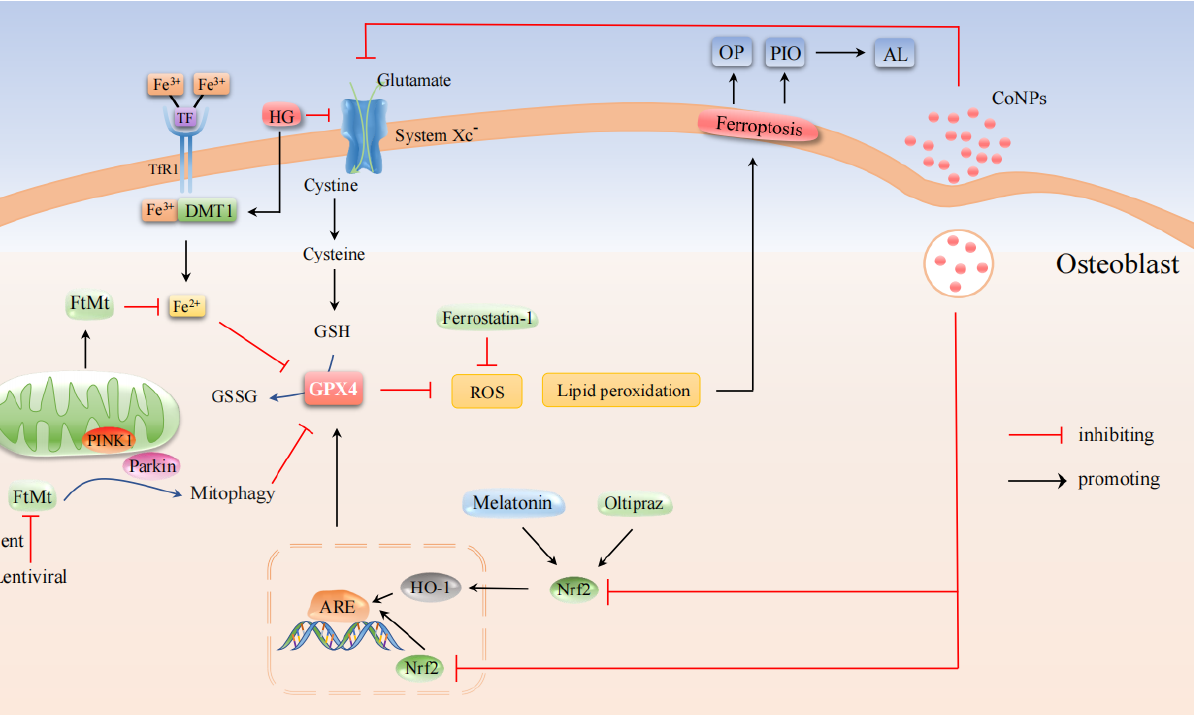
Figure 2. Molecular pathways in the regulation of OP-associated osteoblasts by ferroptosis. Melatonin inhibited osteoblast ferroptosis by activating Nrf2/HO-1 signaling and increasing GPX4 and SLC7A11 activity. Blockade of ferroptosis by the Nrf2 activator Oltipraz significantly ameliorated implanted particle-induced PIO. FtMt attenuated osteoblast ferroptosis by reducing the amount of free Fe 2+ in the mitochondria.